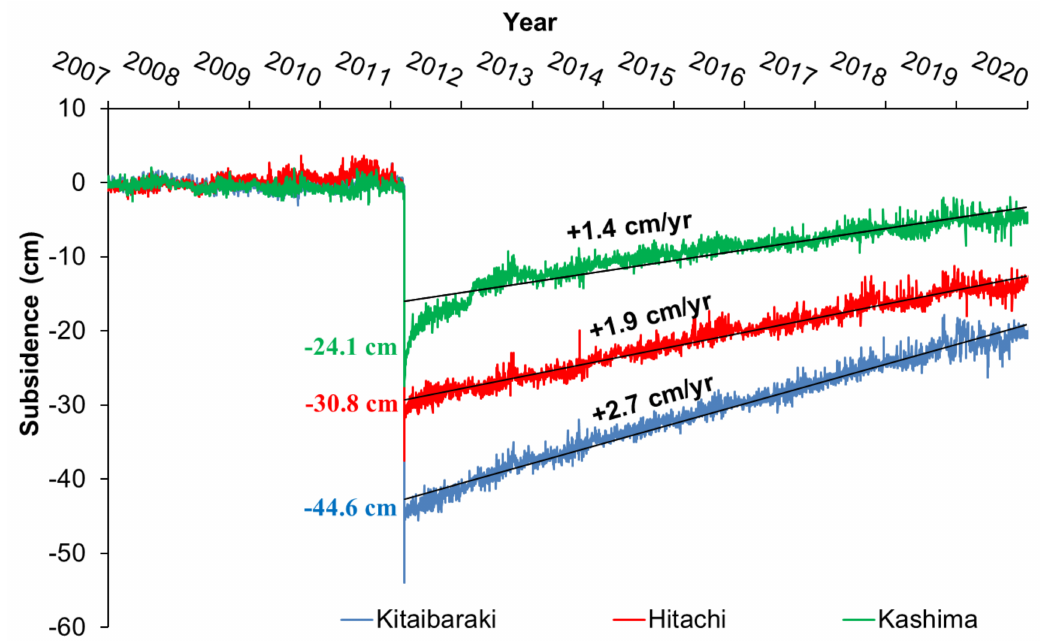
Figure 3. Land surface deformation measured at GNSS observation stations at Kitaibaraki, Hitachi, and Kashima by GSI (blue, red, and green points, respectively, as given in Figure 1). The amount of initial subsidence is defined as the mean subsidence shortly after the earthquake (12 March 2011–31 March 2011). Recovery rates are estimated by linear regressions. Hourly tidal data observed at the tide station of Onahama was downloaded from the website of Japan Meteorological Agency (JMA) (http://www.data.jma.go.jp/gmd/kaiyou/ db/tide/genbo/index.php) (accessed on 5 April 2021), for the correction of the extracted waterline (obtained from satellite images) to determine the shoreline position, which is defined at T.P. 0 m. Note that T.P. 0 m is very close to mean water level of the study